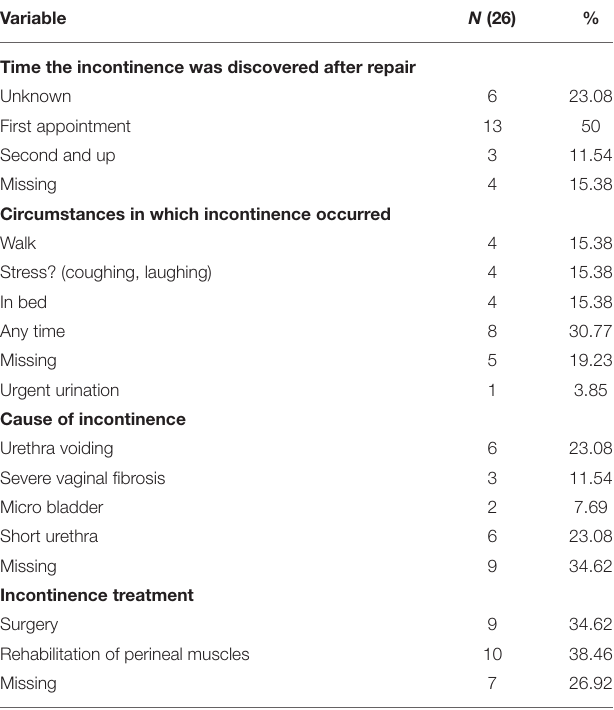
TABLE 3 | Profile of care for women with residual incontinence among women who have benefited from fistula closure in sites supported by the Fistula Care Plus project in the Democratic Republic of the Congo from 2017–2019 ( n =